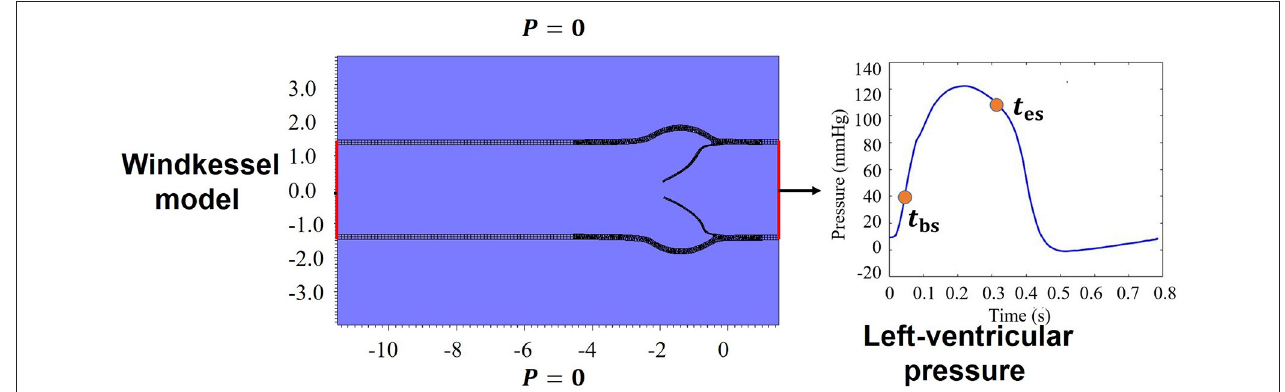
FIGURE 4 | Boundary conditions for the aortic valve (AV) model.